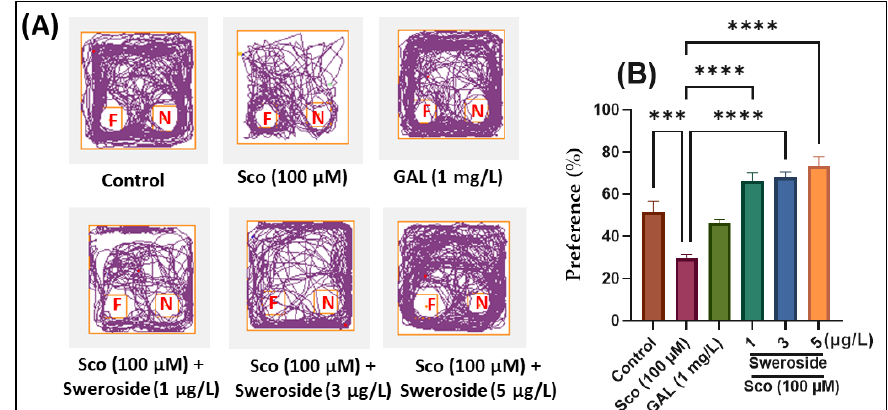
Figure 3. Evaluation of recognition memory in Sco-treated zebrafish subjected to sweroside treatment at doses of 2.79, 8.35, and 13.95 nM in the NOR test: ( A ) Representative tracking locomotion patterns in various groups; ( B ) Preference (%). Data are presented as means ± S.E.M. ( n = 10 animals per group). *** p < 0.0001 and **** p < 0.00001 (Tukey’s post hoc analyses). Galantamine (GAL, 2.71 μ M) was used as reference positive drug.